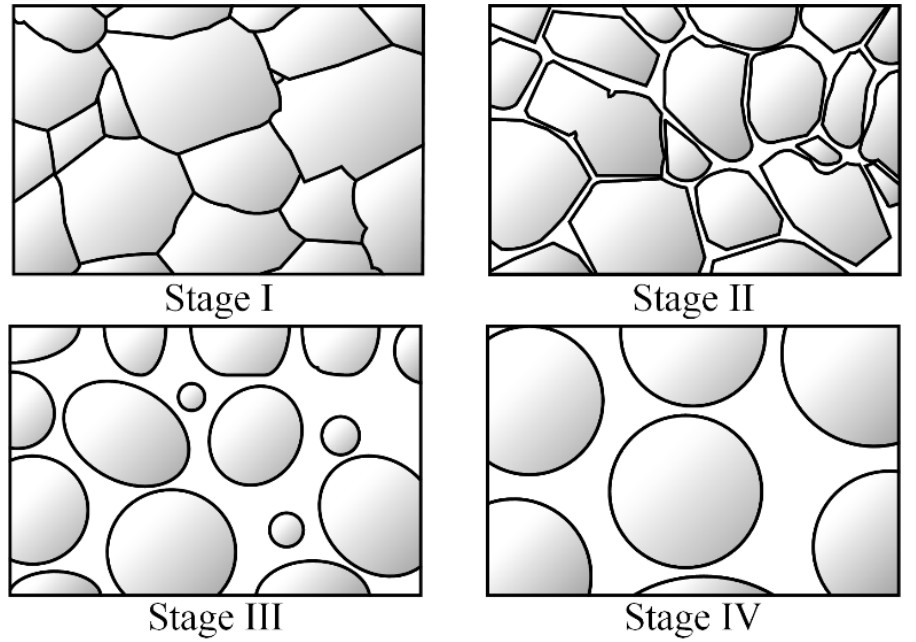
Figure 11. Schematic diagram of the semi-solid-state evolution process.